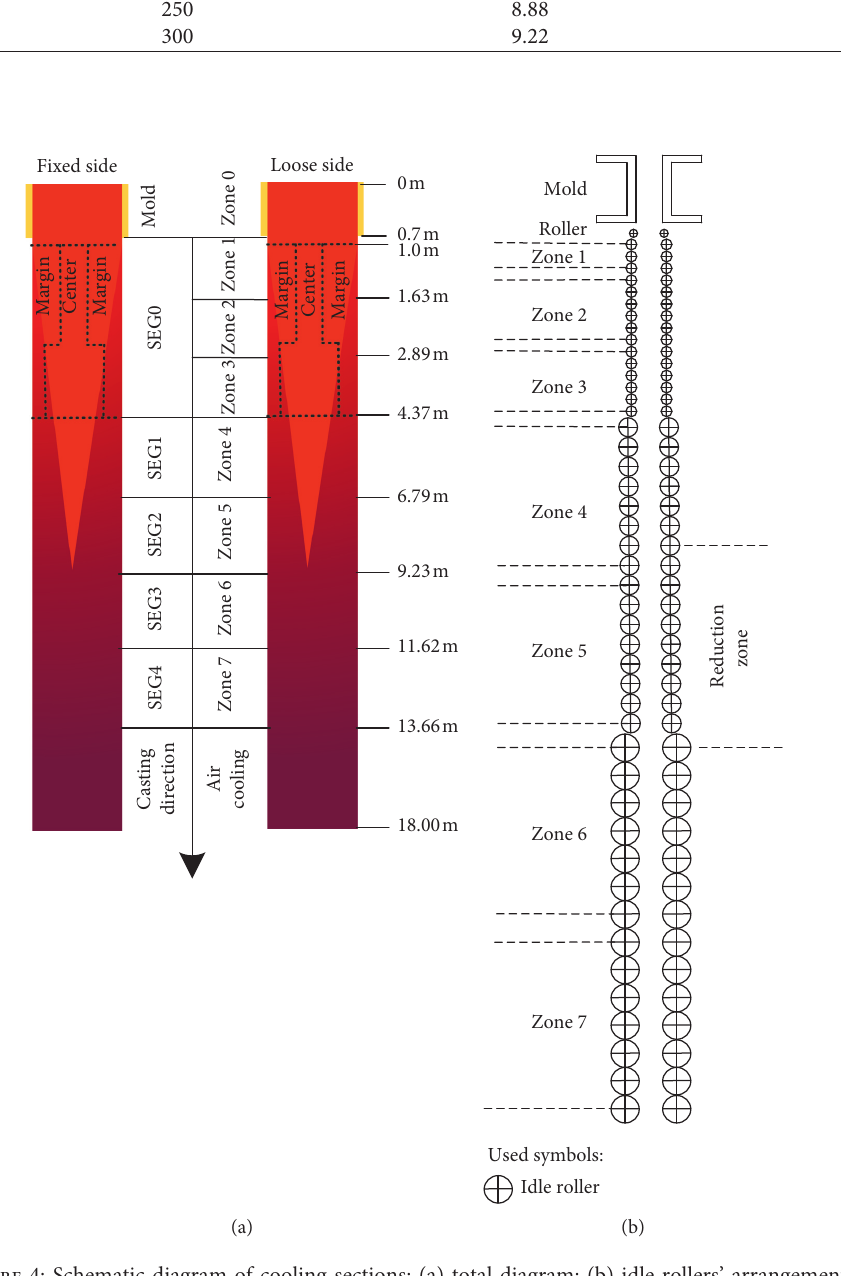
Figure 4: Schematic diagram of cooling sections: (a) total diagram; (b) idle rollers’